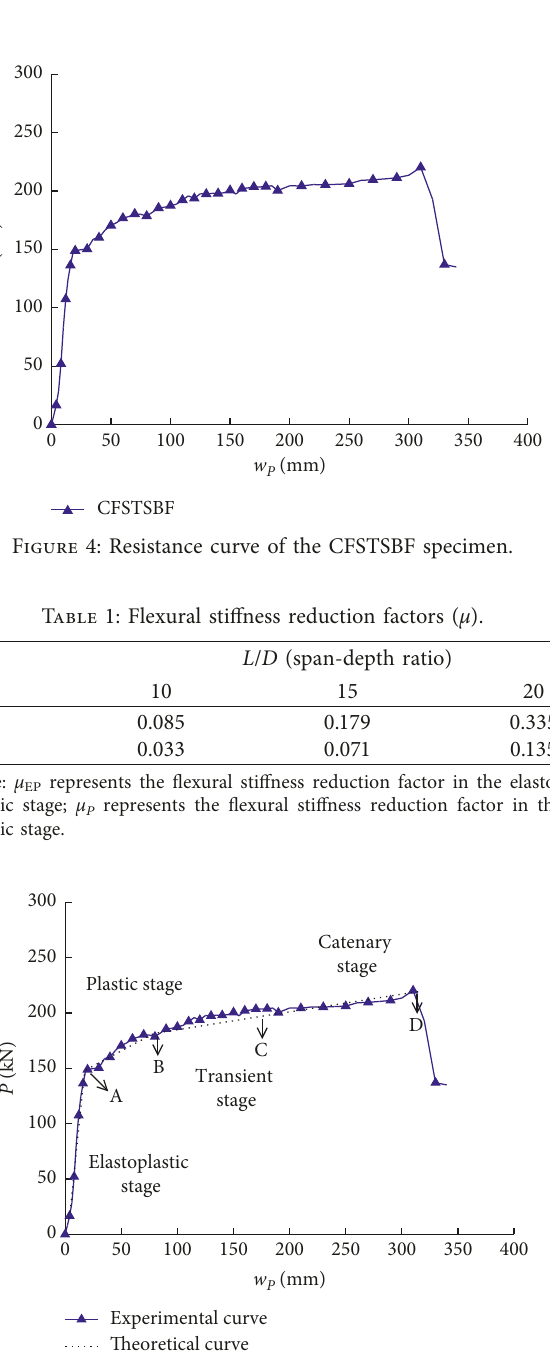
Figure 5: Experimental and theoretical resistance curves of the CFSTSBF specimen.